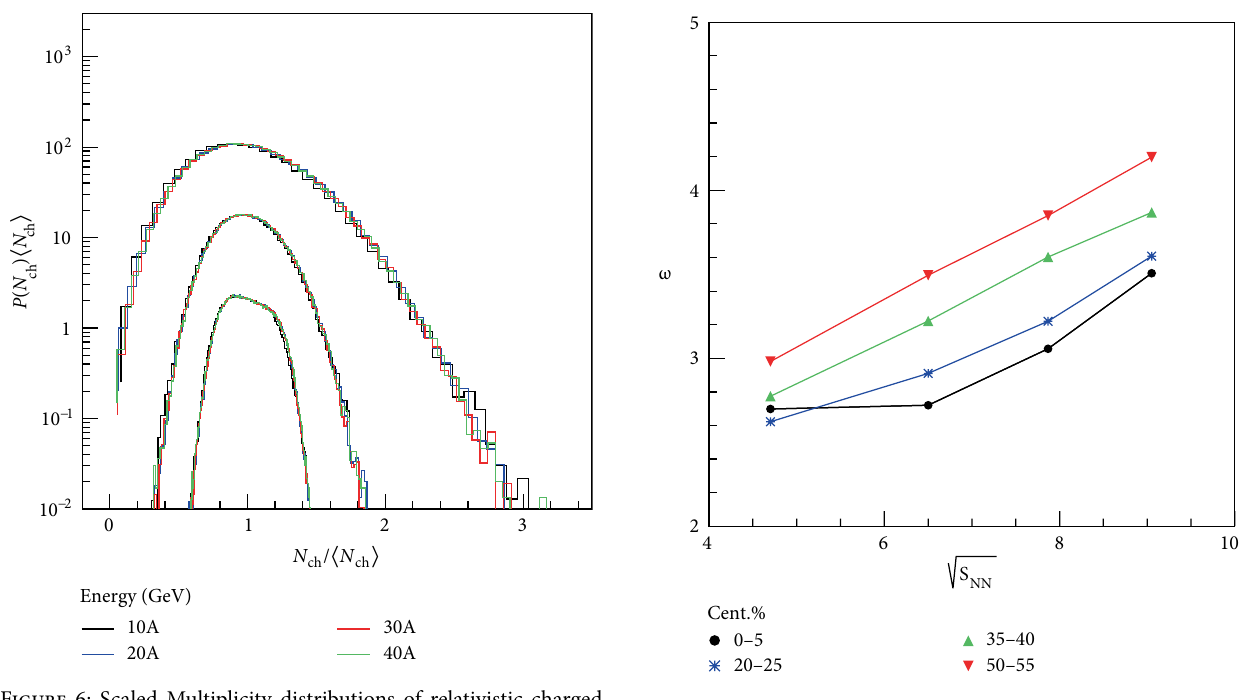
Figure 8: Dependence of scaled variance, 𝜔 on beam